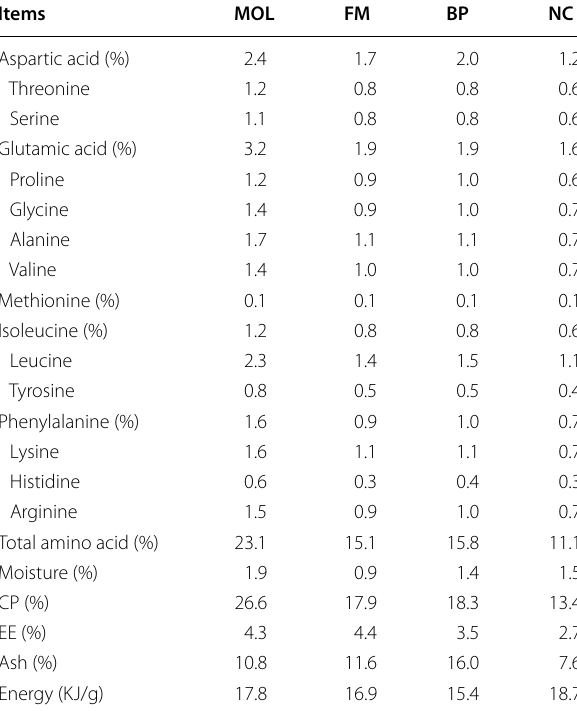
Table 2 Analyzed amino acid and nutrients